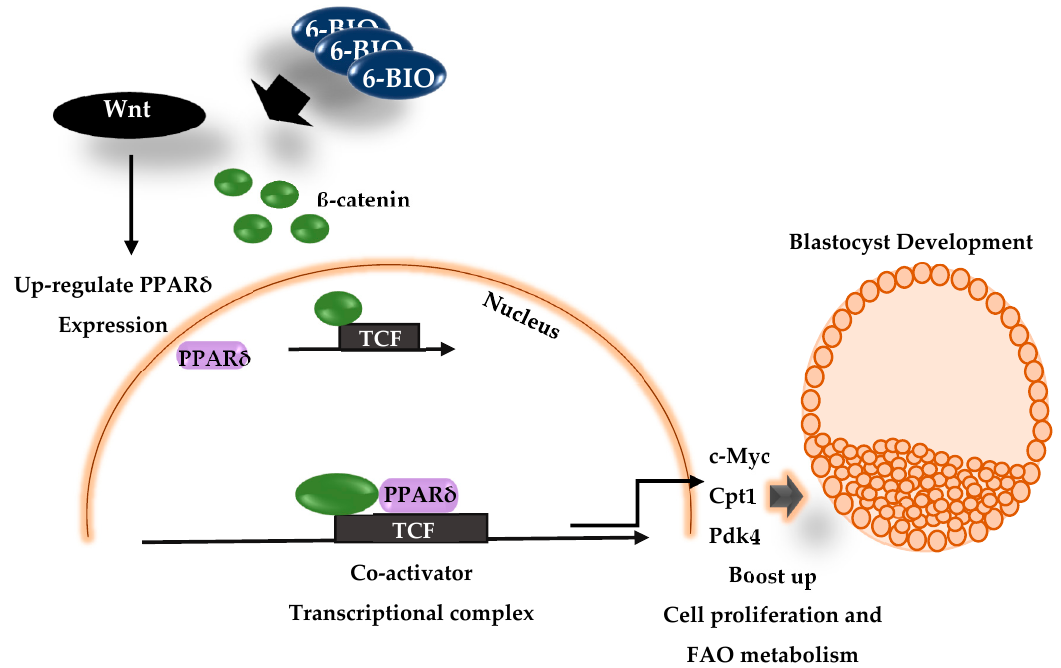
Figure 8. A hypothetical model for Wnt induced PPAR δ expression during bovine embryonic development. Exogenous stimulation of Wnt activity by 6-Bio induced PPAR δ expression which co-localizes with β -catenin to make a transcriptional co-activator complex. The activator complex synergistically regulates Wnt directed genes expression and positively influence cell proliferation activity and FAO metabolism during bovine BL development and hatching. Figure S1: Mean florescence intensities of β -catenin in control and 6-Bio treated groups at di ff erent stages of embryonic development, Figure S2: E ff ect of dose dependent inhibition of PPAR δ function on BL development and hatching rate, Figure S3: Brdu proliferation assay in Wnt agonist and PPAR δ antagonist treated group, Figure S4: Quantification analysis of β -catenin and PPAR δ expression, Table S1: List of qRT-PCR primers, Table S2: List of antibodies, Table S3: E ff ect of PPAR δ inhibitor on bovine blastocyst development and